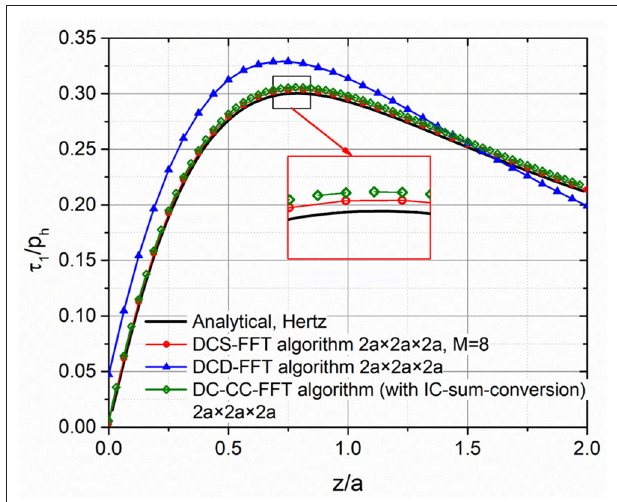
FIGURE 12 | Comparison of the algorithms of DCS-FFT, DCD-FFT and DC-CC-FFT with IC-sum conversion. The physical domains are marked as x y z , and M 8 means the number of segments used in the IC × × =